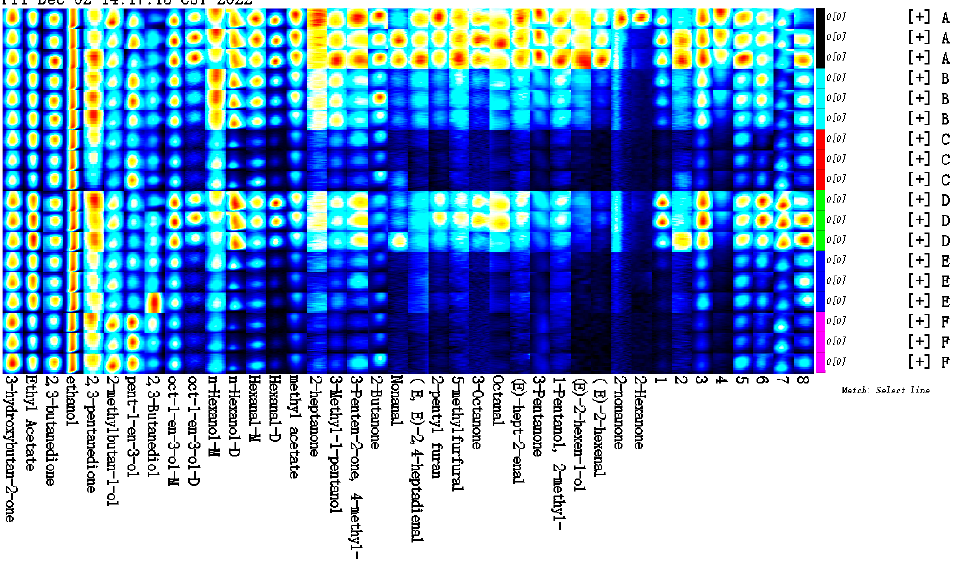
Figure 13. Fingerprint of volatile flavour compounds detected in crucian carp muscle after treat- ment with different concentrations of vanillin. Note: A-control; B-0.50 g/L; C-0.75 g/L; D-1.00 g/L; E-1.25 g/L; and F-1.50 E-1.25 g/L; and F-1.50 g/L.